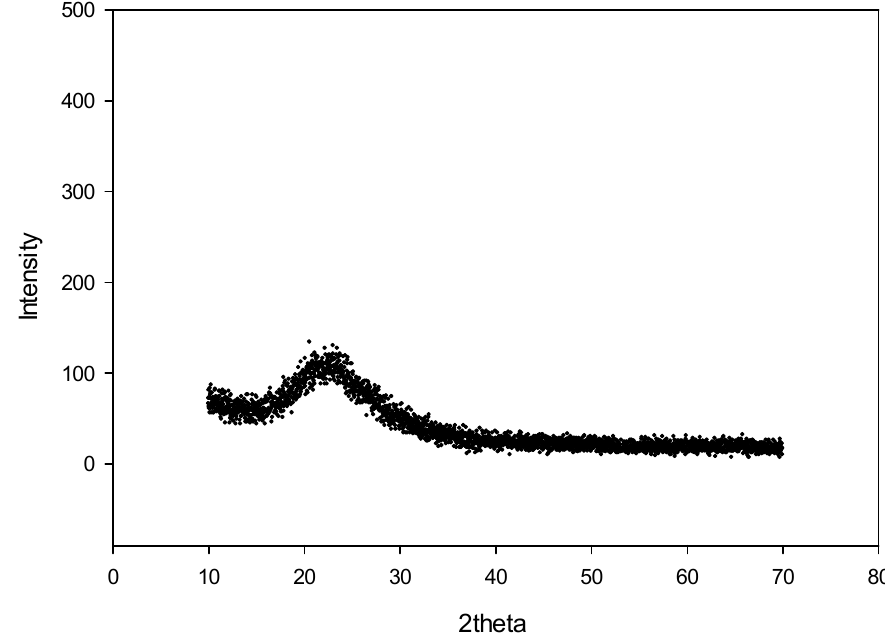
Figure 3. XRD analysis of geothermal silica after acid leaching.